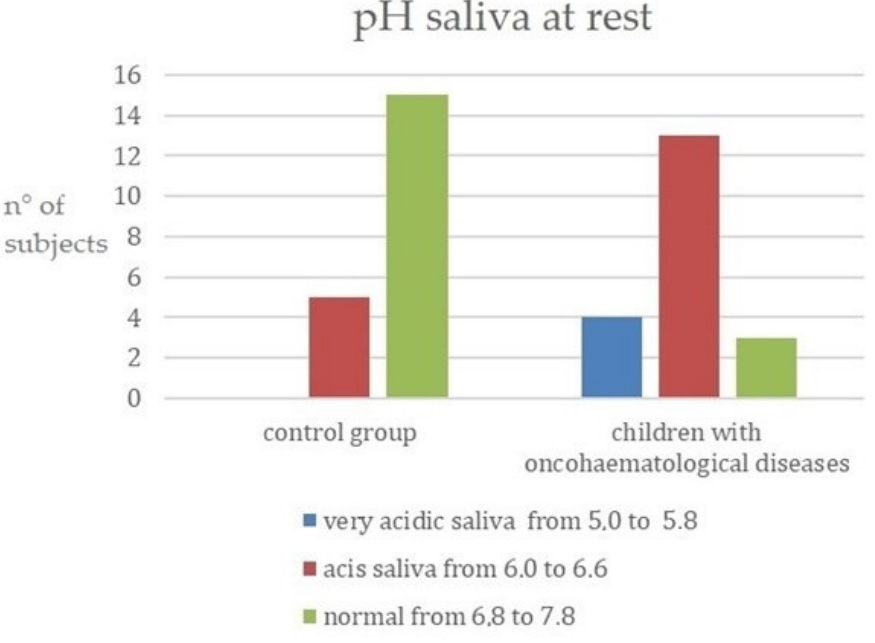
Figure 3. pH of saliva at rest. (Y axis: n° of subjects = number of subjects for each category).